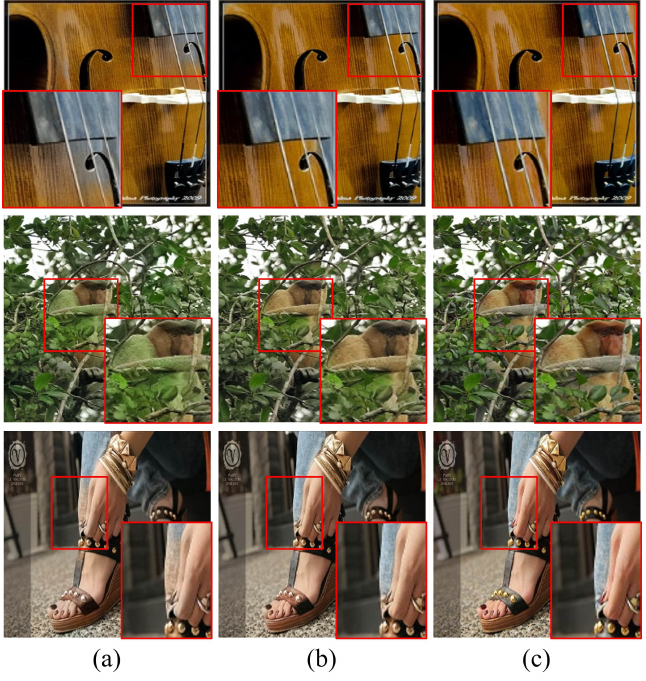
Figure 5. Comparison with respect to color bleeding artifacts. ( a ) Results of Zhang’s CNN model [7]. ( b ) Results of the proposed HCoTnet. ( c ) Ground